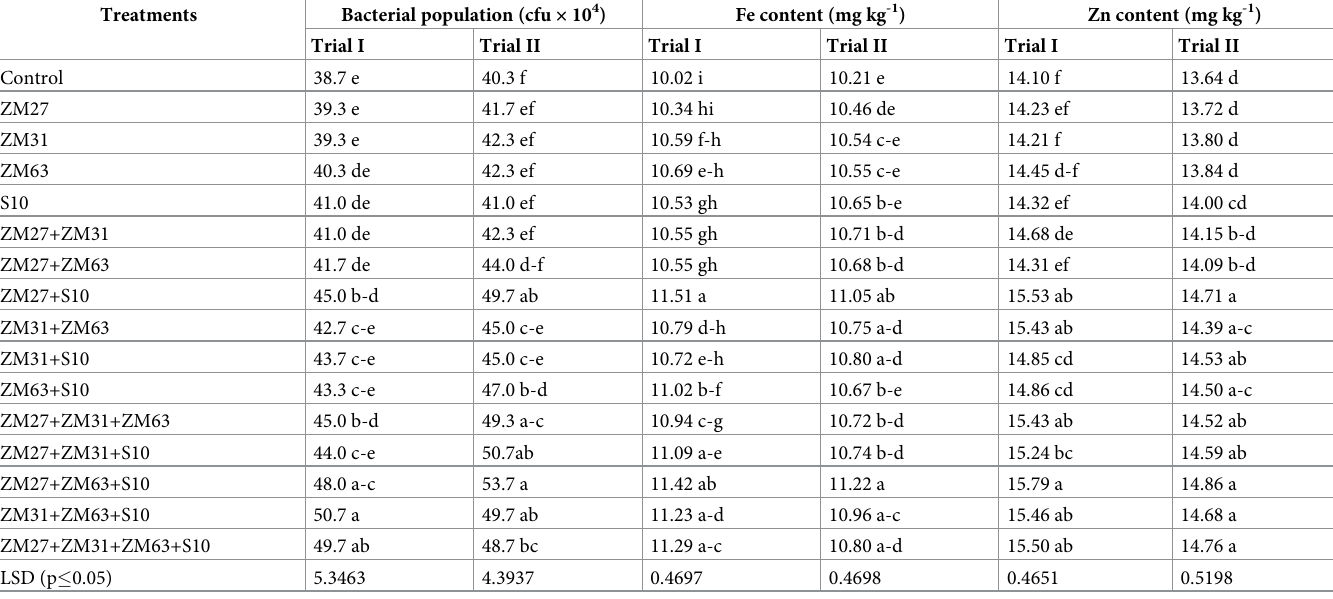
Table 1. Effects of novel bio-inoculants on bacterial population in rhizosphere and iron & zinc content in the shoot of wheat in a pot trial.